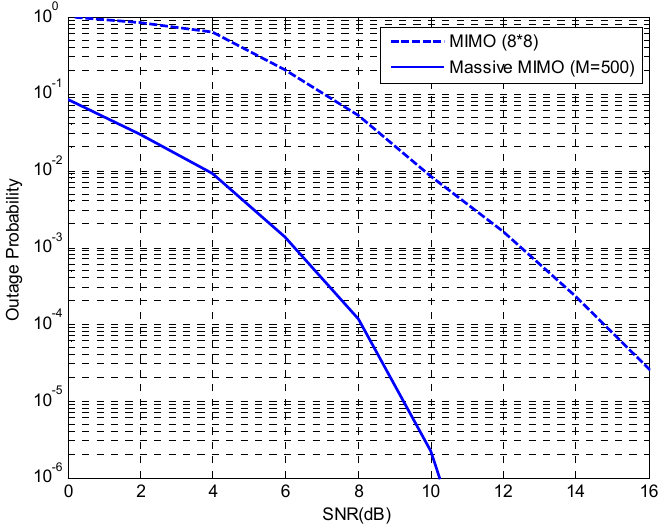
Figure 12. Comparison between Conventional MIMO and Massive MIMO Systems in term of Outage